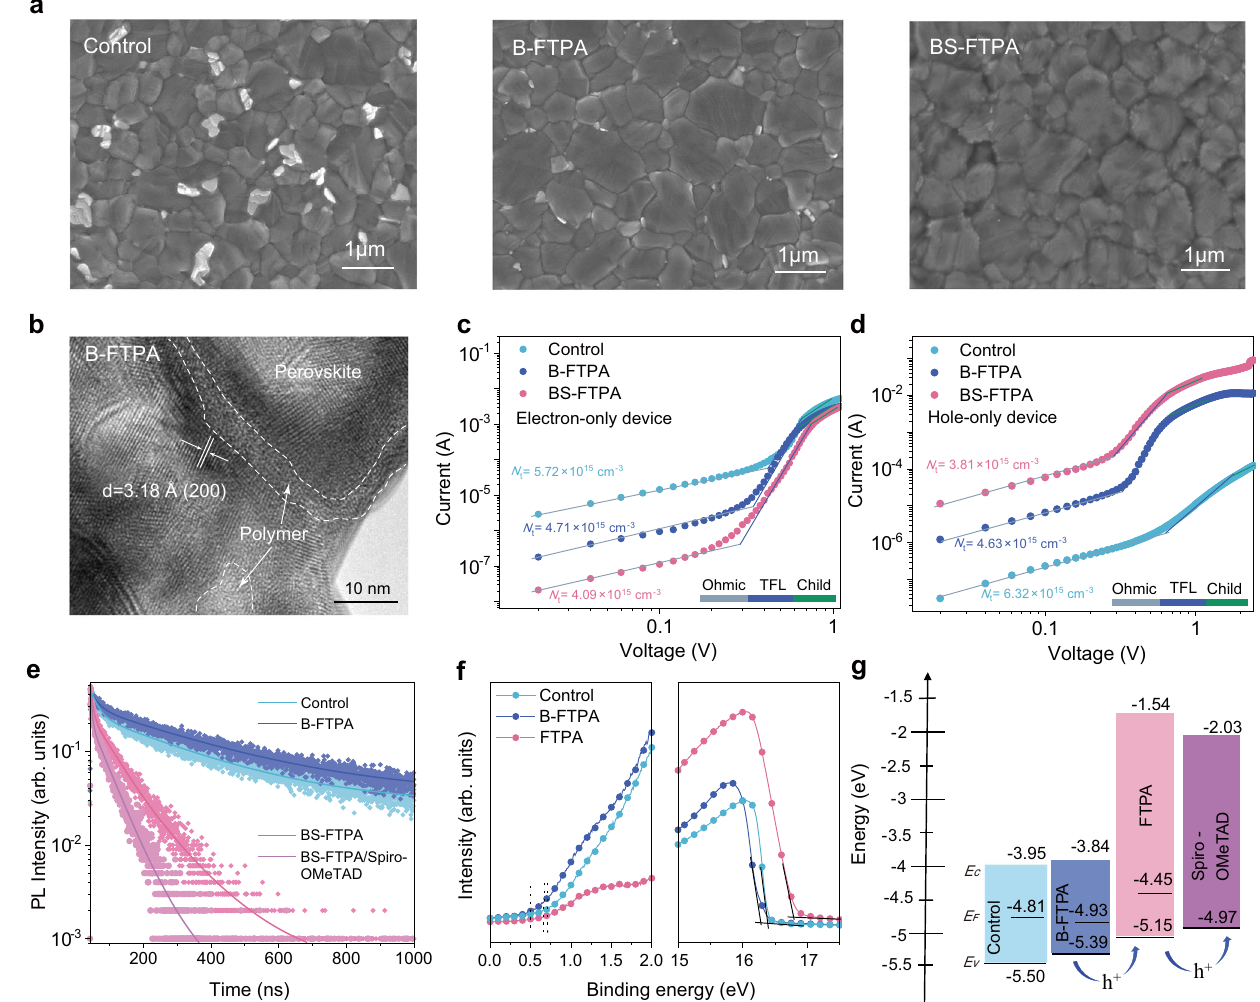
Fig. 3 | Morphology, carrier extraction and energy level behaviors of the con- trol, B-FTPA and BS-FTPA perovskite fi lms. B-FTPA is the perovskite fi lm with FTPA in the bulk, and BS-FTPA is the fi lm further spin-coated 2mgmL − 1 FTPA and annealed for in-situ polymerizing on the surface of the B-FTPA. a Top-view SEM images. b HR-TEM image clearly shows the polymerized FTPA surround the grain boundaries of perovskite. J - V curves of c the electron-only device (FTO/SnO 2 /per- ovskite/PCBM/Ag) and d the hole-only device (FTO/PEDOT PSS/perovskite/Spiro-